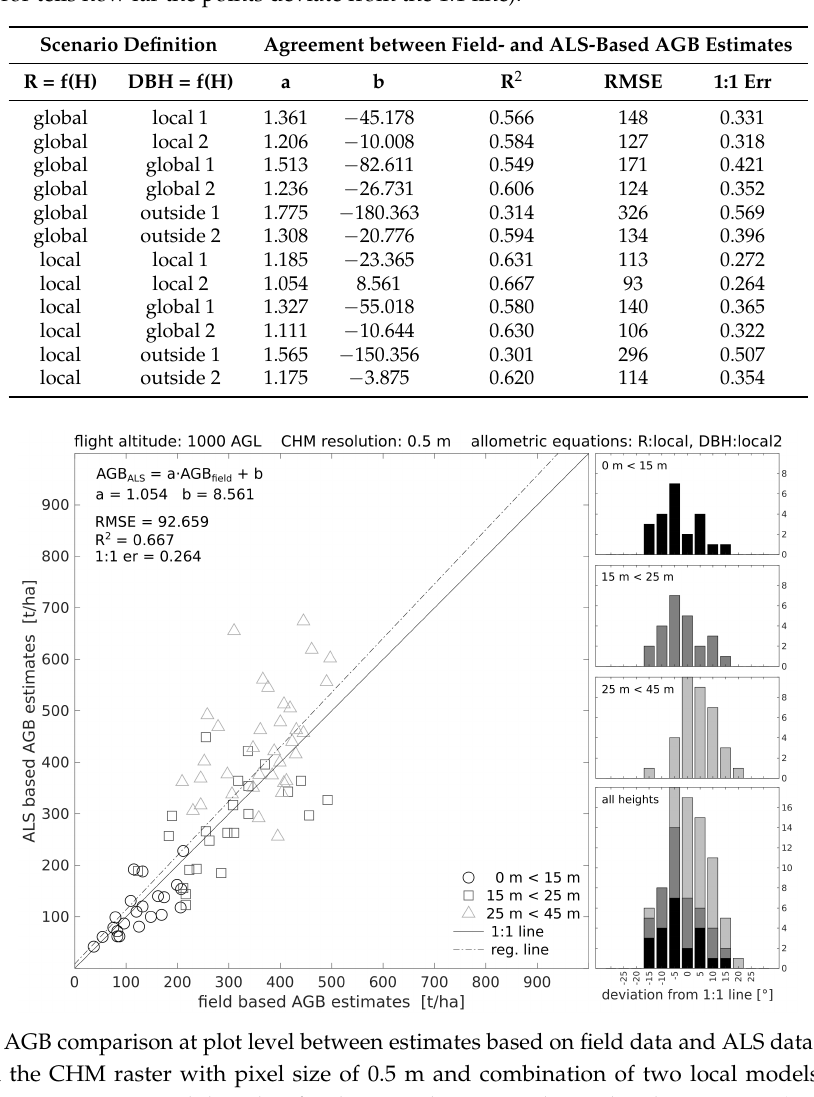
Table 5. Numerical comparison of different scenarios for AGB estimation from ALS data. The first two columns describe the scenario itself by specifying which type of allometric equation was used in the tree detection phase for estimating tree crown radius (R = f(H)) and for stem diameter estimation (DBH = f(H)). The remaining variables evaluate the agreement between field- and ALS-based estimates of AGB (R 2 and RMSE were computed based on linear regression with equation AGB ALS = a · AGB field + b; 1:1 error tells how far the points deviate from the 1:1 line).